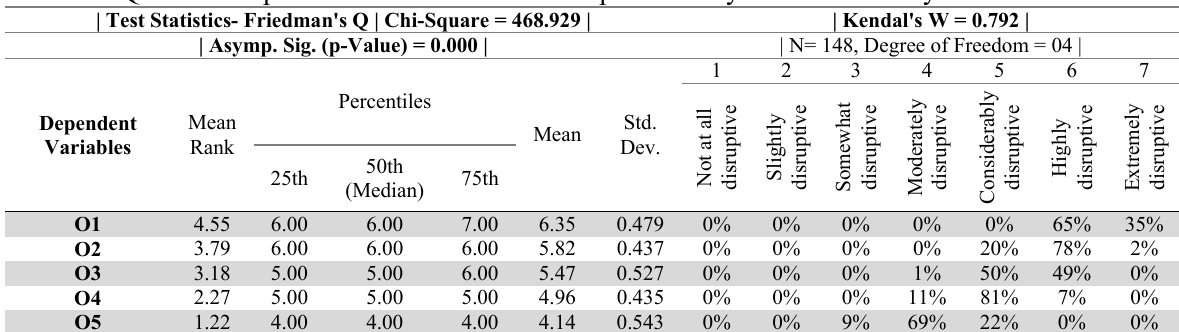
Friedman Q and descriptive statistics- Level of disruptiveness by 1 hour reliability issue scenarios | Test Statistics- Friedman's Q | Chi-Square = 468.929